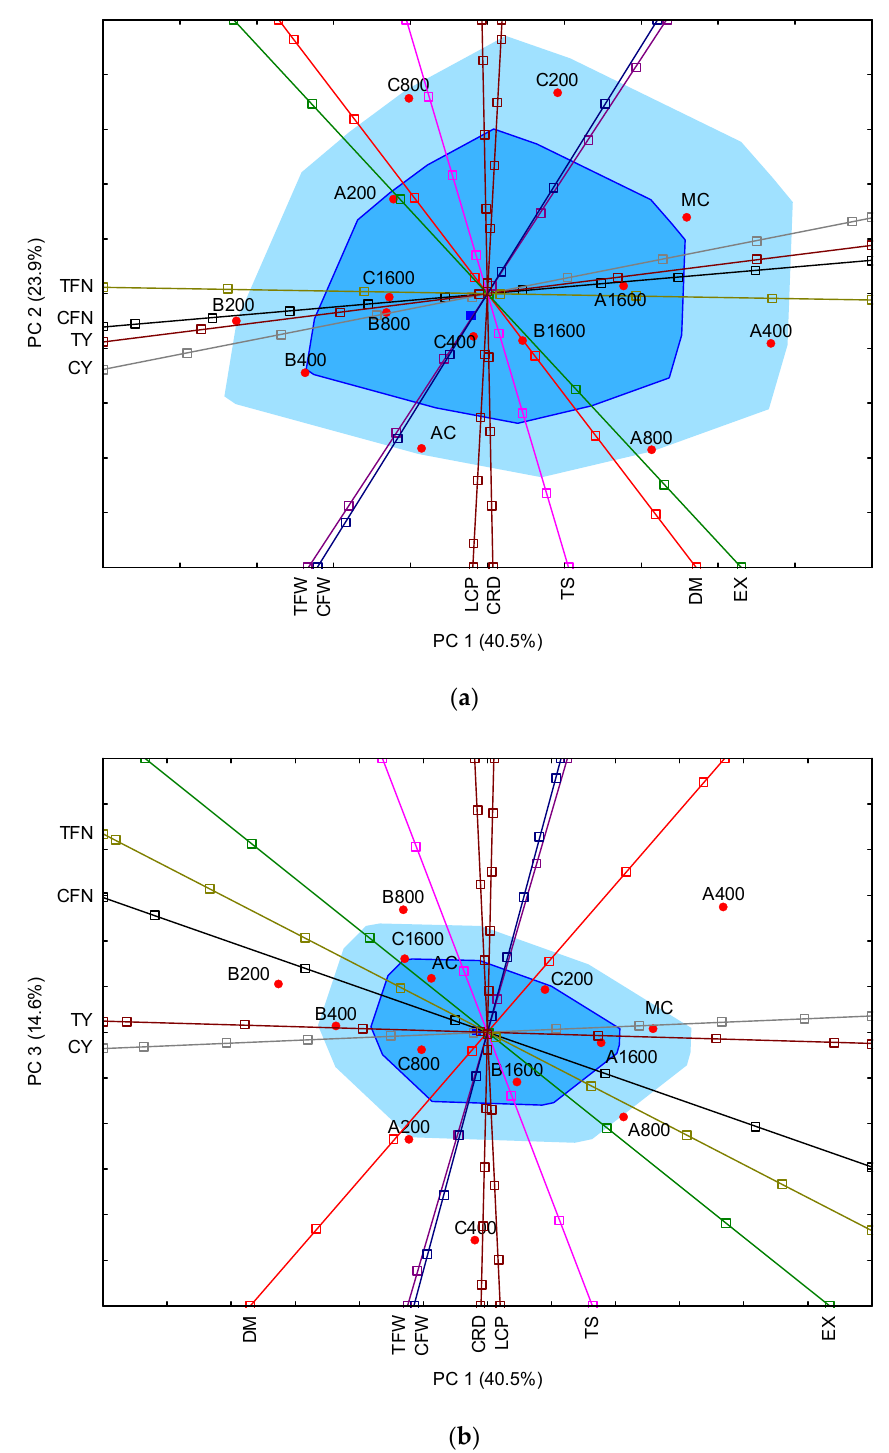
Figure 3. ( a , b ) Principal component analysis (PCA) biplot of the tomato yield, yield components and content of organic compounds. The dark blue square denotes the Tukey median, the blue square is the bagplot, the light blue square is the bagplot cover. Key: A, B and C—bio-fertilizers;